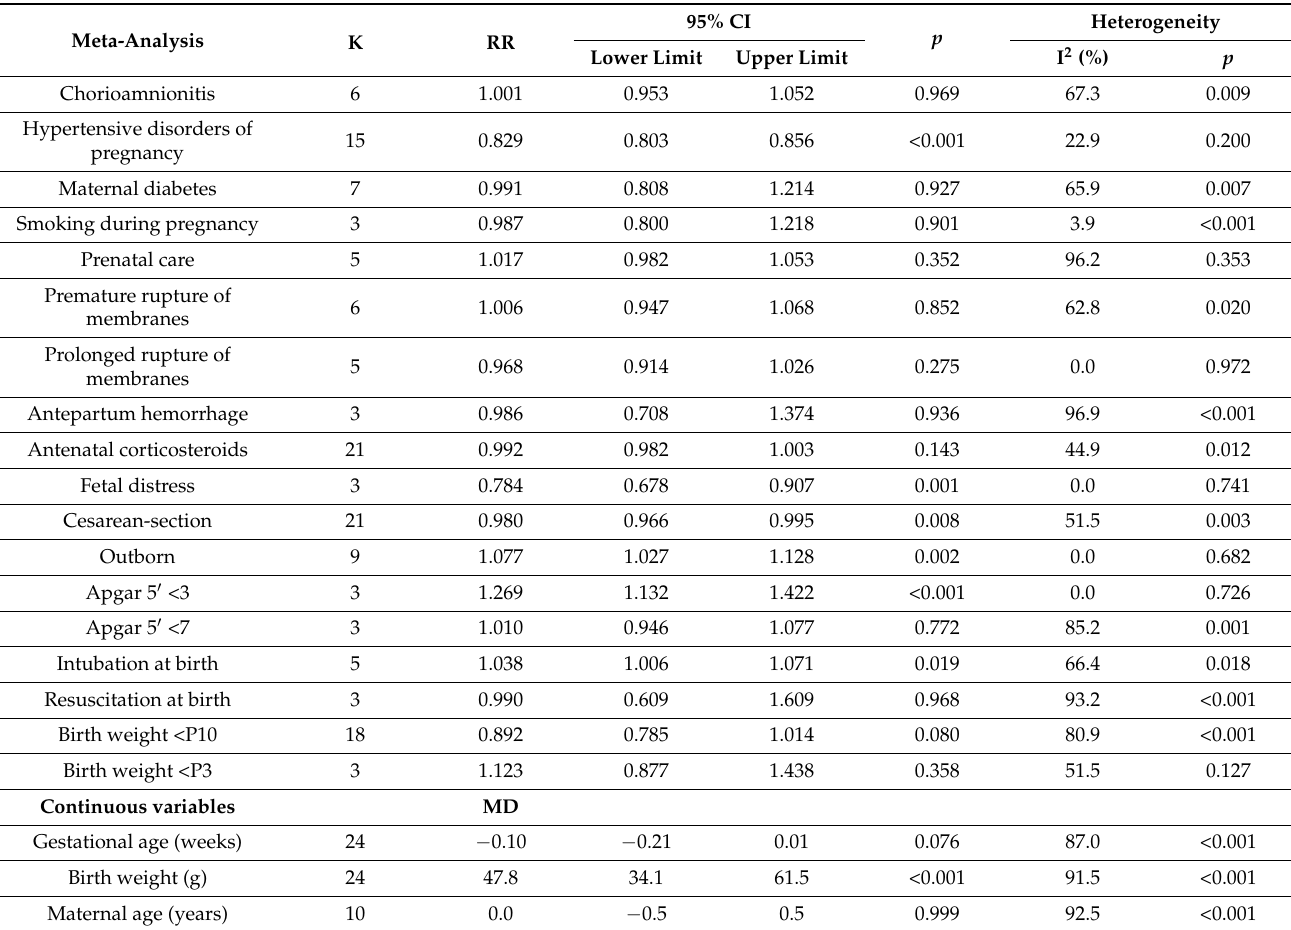
Table 1. Meta-analyses on the association between obstetric and perinatal characteristics of preterm infants and male sex.